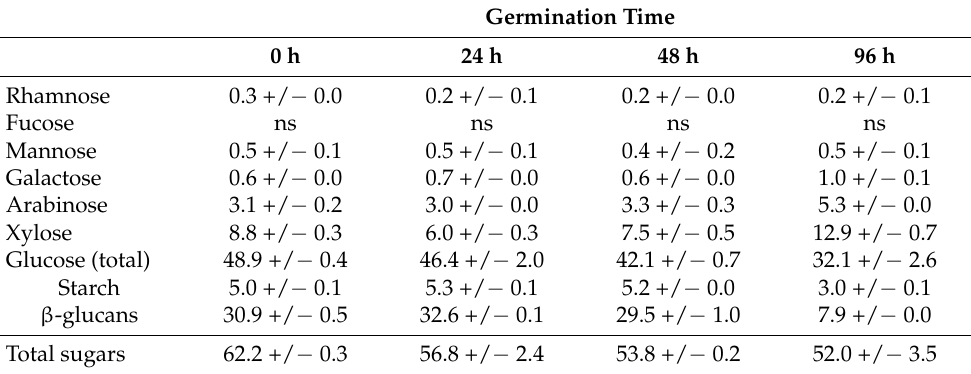
Table 1. Sugar composition of the alcohol-insoluble residues (AIR) of wild type grains (WT, ac- cession Bd21-3) at different stages of germination (time counted after the imbibition step). Re- sults were obtained by gas chromatography analysis while the specific determination of starch and MLG contents was assayed by HPAEC analysis. The results are expressed as a percentage of AIR dry matter. Germination